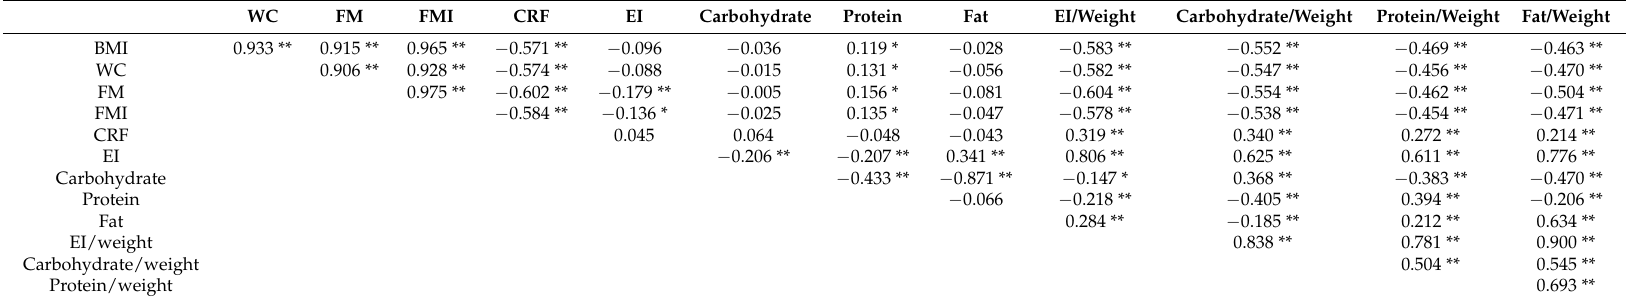
Table 2. Partial correlation coefficients among cardiorespitatory fitness, body composition variables, and dietary factors, controlling for age and